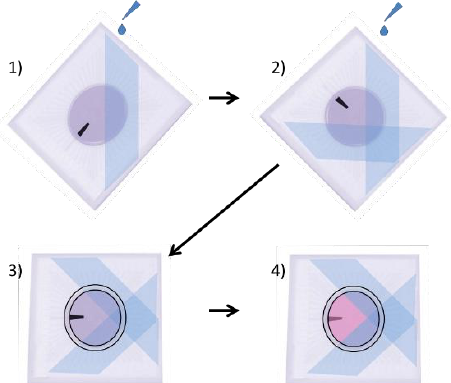
Figure 1. Procedure for coating MEAs with p-HEMA. ( 1 ) MEA is balanced at a 60° angle in a 35 mm dish, and 100 µL of p-HEMA is dripped onto the MEA, taking care to not allow the electrodes in the center of the MEA to be covered with p-HEMA. The MEA is then covered in a 90 mm dish and allowed to dry for 1 h. ( 2 ) The MEA is turned 90°, and p-HEMA is again placed at a 60° angle in a 35 mm dish, and 100 µL of p-HEMA is dripped onto the MEA, again taking care not to allow p-HEMA to drip onto the center electrodes. The MEA is once again covered in a 90 mm dish and allowed to dry for 1 h. ( 3 ) A PDMS ring is applied to the MEA, and Vaseline is applied around the ring, to prevent leakage of media. ( 4 ) The MEA is coated with 75 µL of Sal-1. (The black bar is provided to help visualize changes in orientation.).